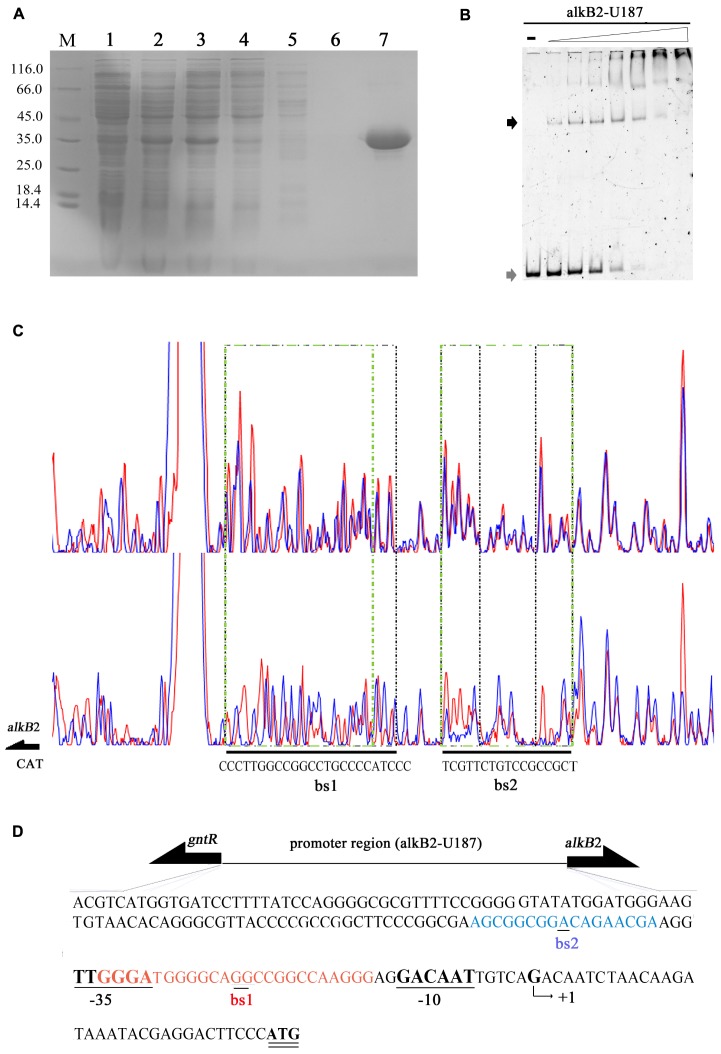
Affinity purification and binding detection of the recombinant CrgA protein to the upstream fragment of alkB2 gene. (A) The SDS-PAGE image of recombinant CrgA protein. M, protein marker (Thermo Fisher Scientific, 14.4 KD–116.0 KD); Lane 1, cell lysis solution before induction; lane 2, cell lysis solution after induction; lane 3, the supernatant of lysed cells; lane 4, the effluent solution; lane 5, solution of first wash; lane 6, solution of last wash and lane 7 the eluted protein solution. (B) Native PAGE image of EMSA assay with the recombinant CrgA protein and the 5′-FAM labeled 187 bp fragments of alkB2 gene (alkB2-U187). The input of alkB2-U187 fragments in each sample was 4 pmol, and the molar ratios of CrgA/alkB2-U187 fragment ranged from 0, 2:1, 4:1, 8:1, 16:1, 32:1, 64:1, and 128:1. The lane marked dash meant the free DNA fragment without protein. The band of free DNA fragments were marked with gray arrow and the conjunct DNA were marked with black arrow. (C) The sequencing profiles of DNase I foot-printing assay performed with CrgA protein and the 5′-FAM labeled 187 bp fragments of alkB2 gene (alkB2-U187). The upper one was the sequence map of the fragment alkB2-U187 without CrgA protein after DNase I digestion; and the lower one was the sequence map of fragment alkB2-U187 binding with CrgA protein in 8:1 molar ratios (protein/DNA) after DNase I digestion. The protected regions were lined with green dashed frame, and marked as bs1 and bs2. (D) Sequence of the upstream region of alkB2 gene. The two CrgA binding site was showed in red font (bs1) and blue font (bs2). The arrow represented the predicted transcriptional start site (TSS, +1), and -10 (GACAAT) and -35 (TTGGGA) regions were underlined.